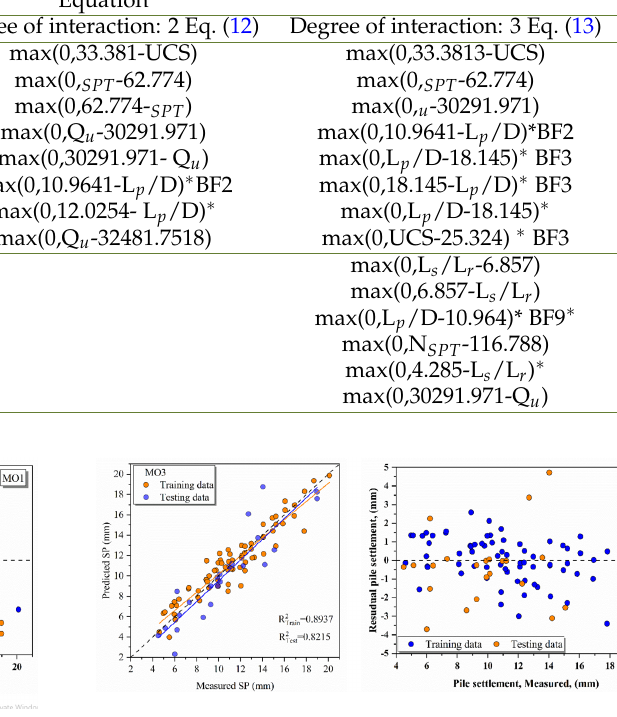
Fig. 7. Comparison between measured and predicted the pile settlement using MO3 for training and testing data (a) model prediction, and (b) residual pile settlement Eq.